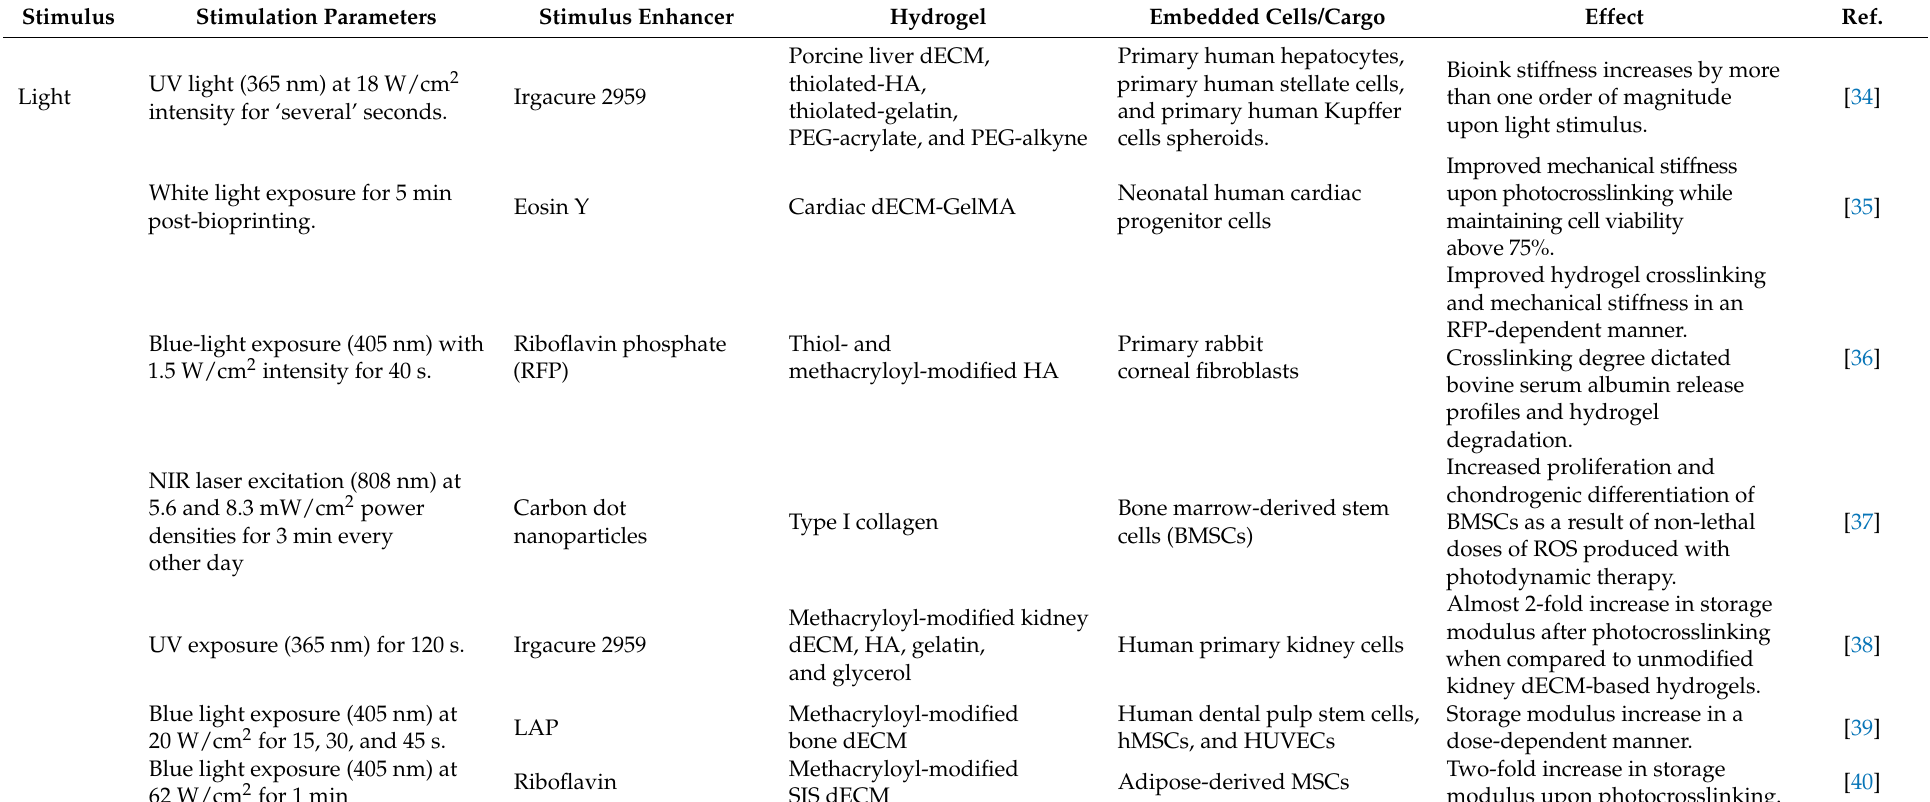
Table 1. Most relevant works implementing external stimuli for improving cellular scaffolding and localized drug delivery from dECM-derived